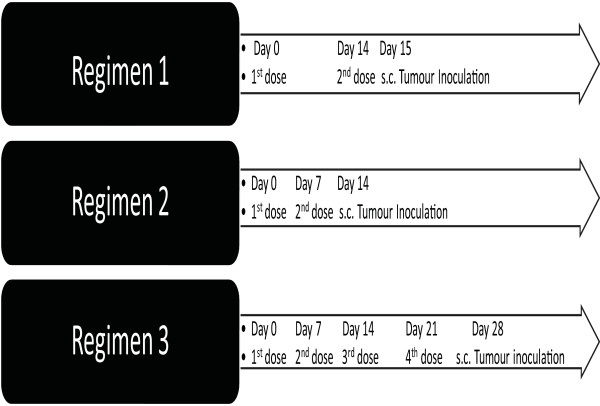
Schematic representation of vaccination schedules. Regimen1 involved two vaccinations (day 0 and 14) with subsequent tumour challenge on day 15. Regimen 2 involved vaccinations on day 0, 7, and tumour challenge on day 14. In regimen 3, four doses of vaccine were given on day 0, 7, 14, and 21 followed by tumour challenge on day 28.